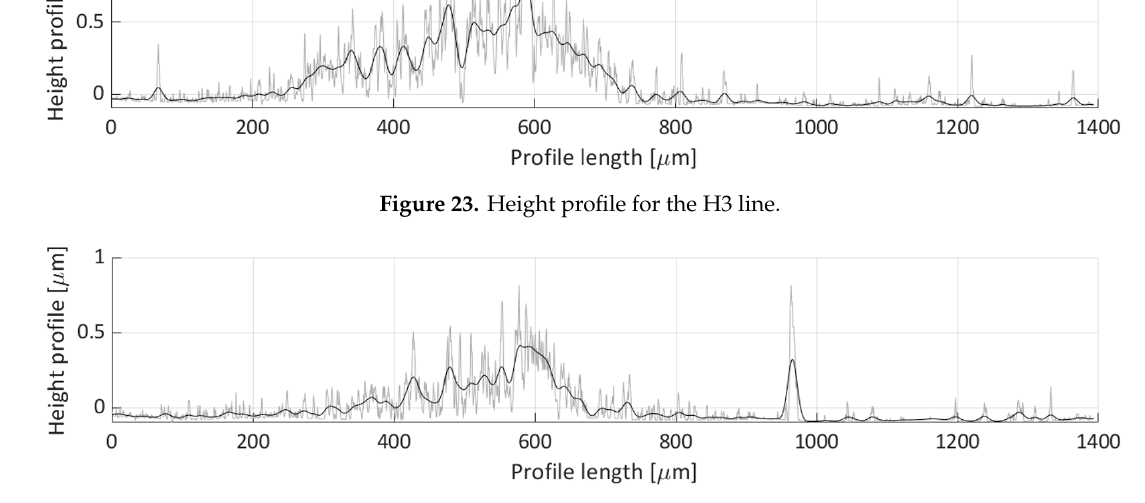
Figure 23. Height profile for the H3 line.